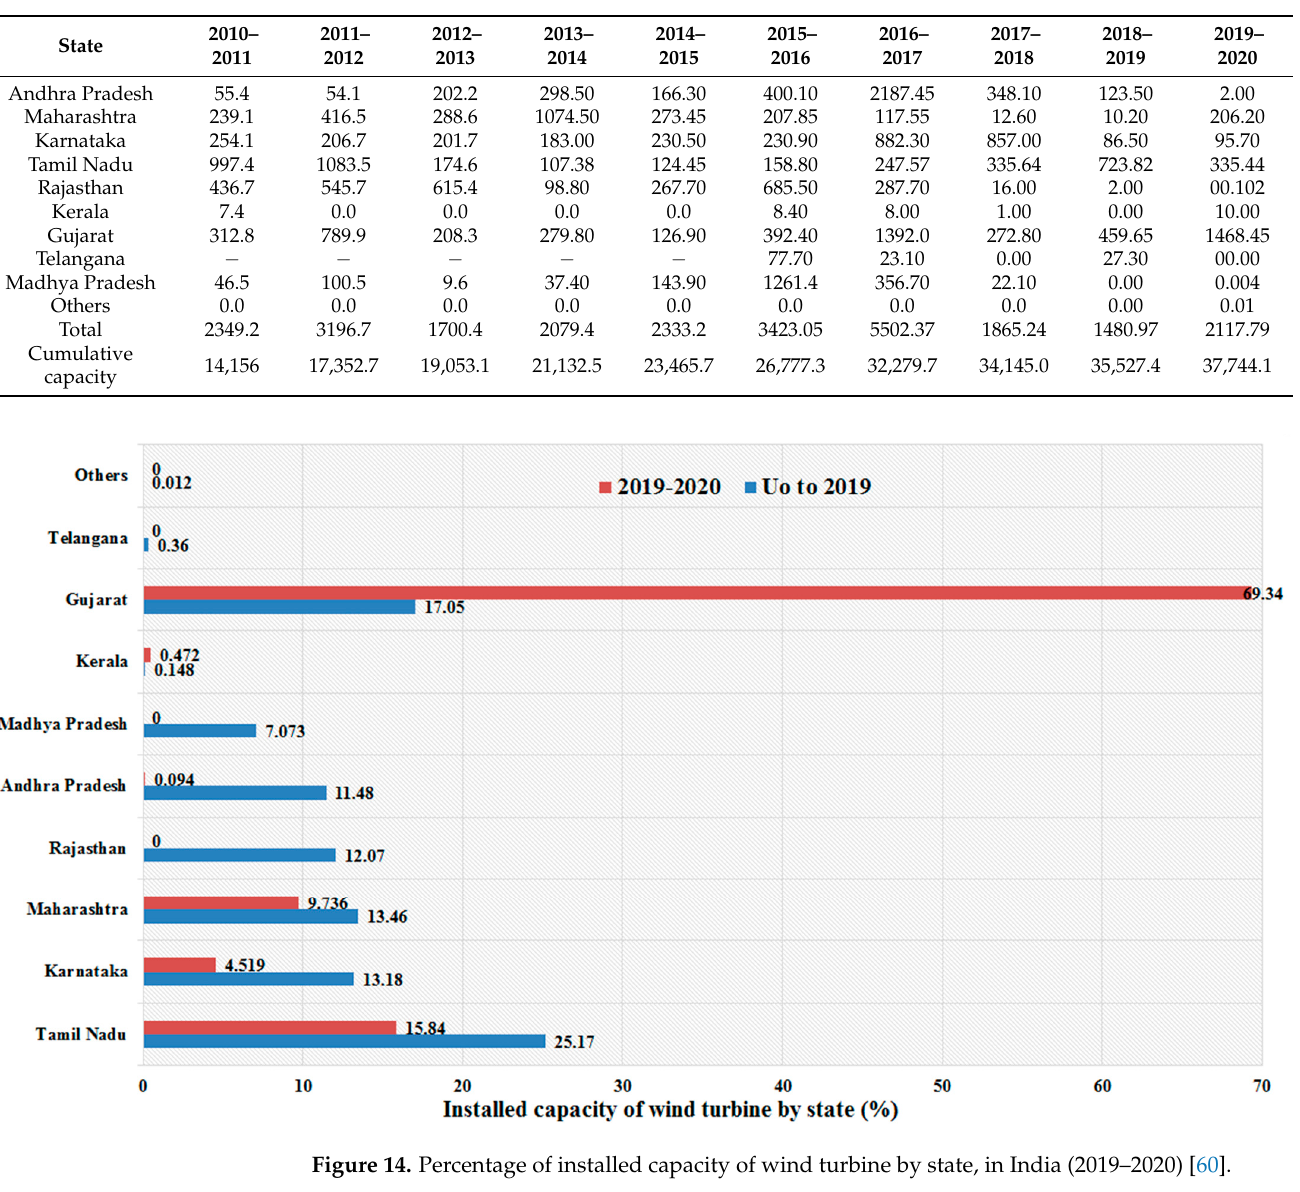
Table 15. Installed wind power capacity (in MW) by year and state, as at 31 March 2019. Source; Indian Wind Energy Association (IWEA) [60] (as at 31 March 2020).